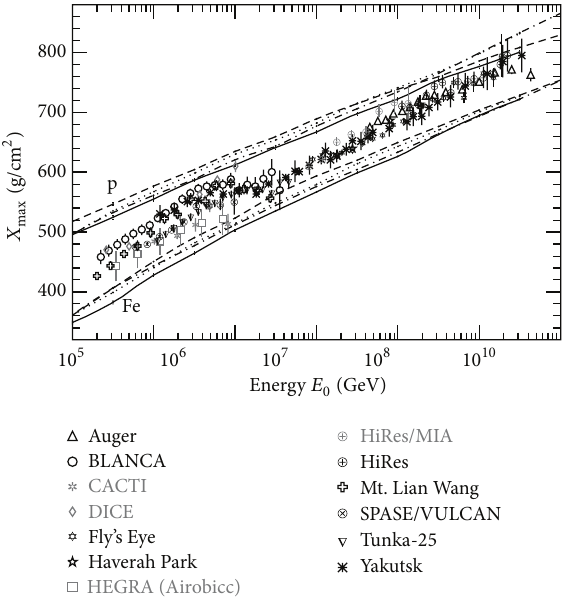
Figure 2: Mean 𝑋 max distribution as a function of energy [16]. The dots are experimental results. The lines are simulation results for proton and iron predicted by Corsika [17] with the hadronic interaction model QGSJET 01 (solid line), QGSJET II-03 (dashed line), SIBYLL (dot line), and EPOS 1.6 (dot-dashed line) [18, 19]. Tower FT: 16